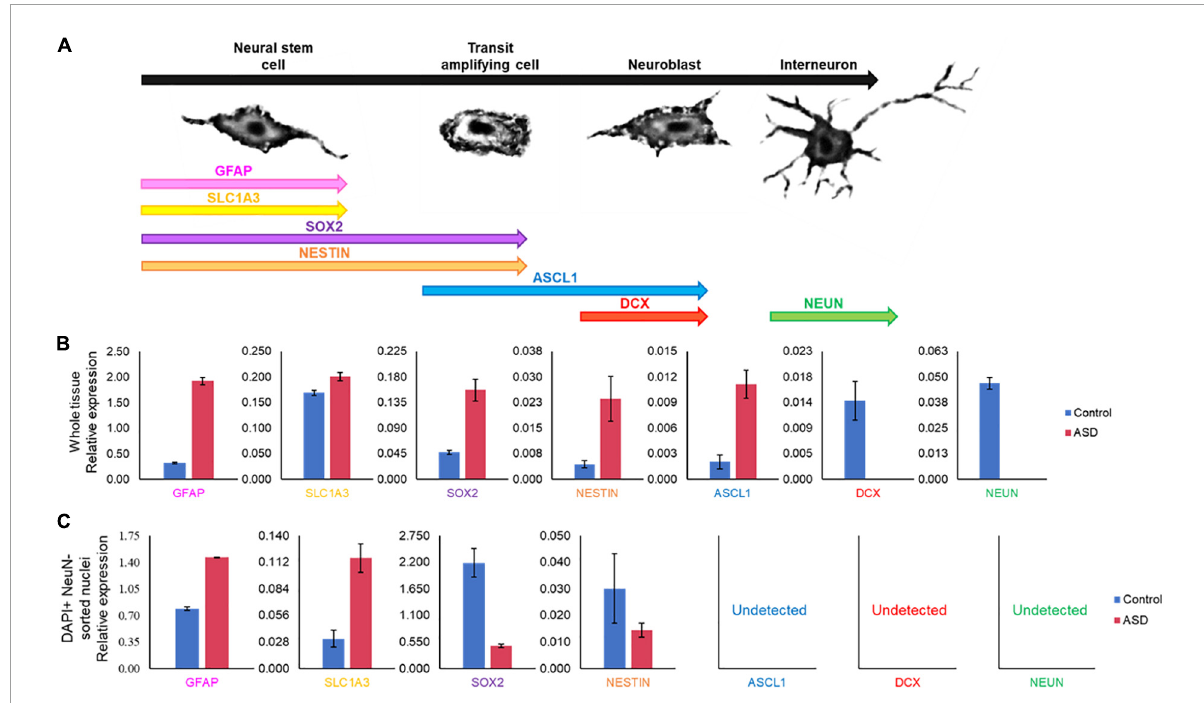
FIGURE9 Gene expression pattern in SVZ of ASD and control patients’ samples demonstrates divergent populations of cell stages. (A) SVZ cell types and specific cell stage gene markers. (B) qPCR expression analysis of cell stage gene markers from the same postmortem SVZ brain tissue samples as in Figure 8 . (C) qPCR expression analysis of cell stage gene markers in sorted nuclei from Figure 8